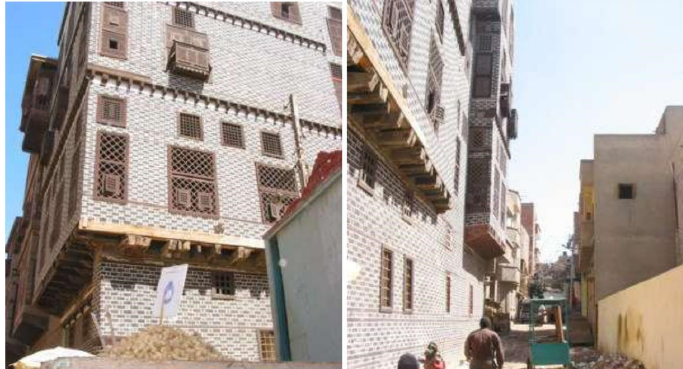
Figure 11. Rosetta